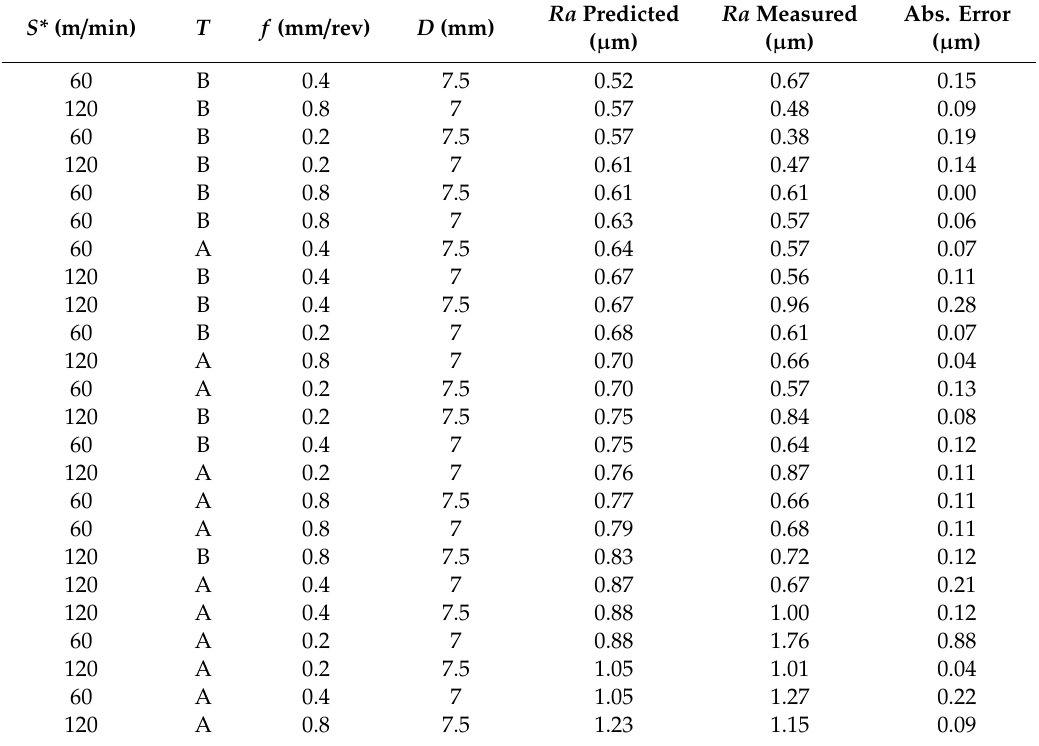
Table 7. Predicted Ra , measured Ra , and absolute error for levels and e ff ects